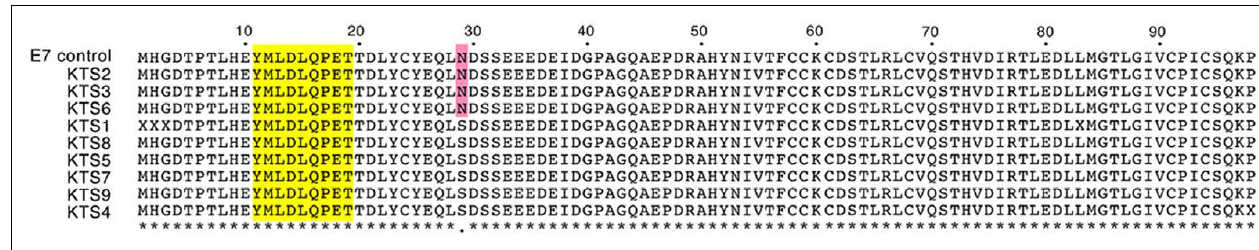
tumor samples: N 29 in KTS2, KTS3, and KTS6 marked as red, and S 29 in the remaining samples.The E7 11–19 YMLDLQPETT-cell epitope highlighted as yellow was conserved in all samples. Results are representative of two independent sequencing reactions performed on nine different tumor DNA